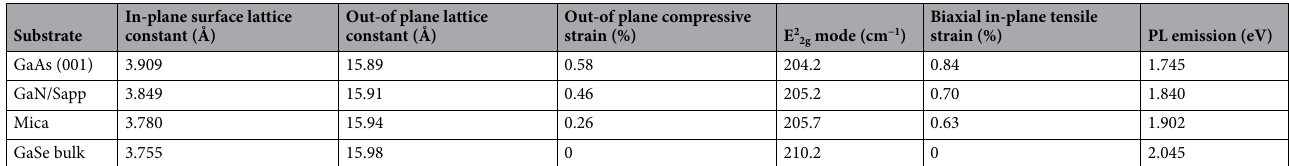
Table 1. Extracted lattice parameters and optical properties of the GaSe layers grown on different substrates and the GaSe bulk.